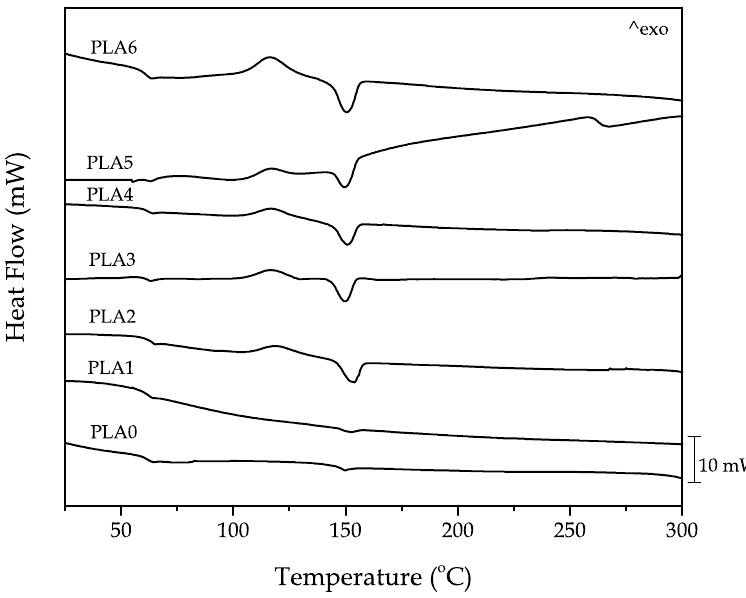
Figure 4. A comparative plot of the differential scanning calorimetry (DSC) thermograms during second heating corresponding to the injection-molded polylactide (PLA) pieces subjected to different reprocessing cycles. Table 3. Thermal properties of the injection-molded polylactide (PLA) pieces subjected to different reprocessing cycles in terms of glass transition temperature ( T g ), cold crystallization enthalpy ( Δ H CC ), cold crystallization temperature ( T cc ), melting enthalpy ( Δ H m ), melting temperature (T m ), and maximum degree of crystallinity ( χ c_max ).